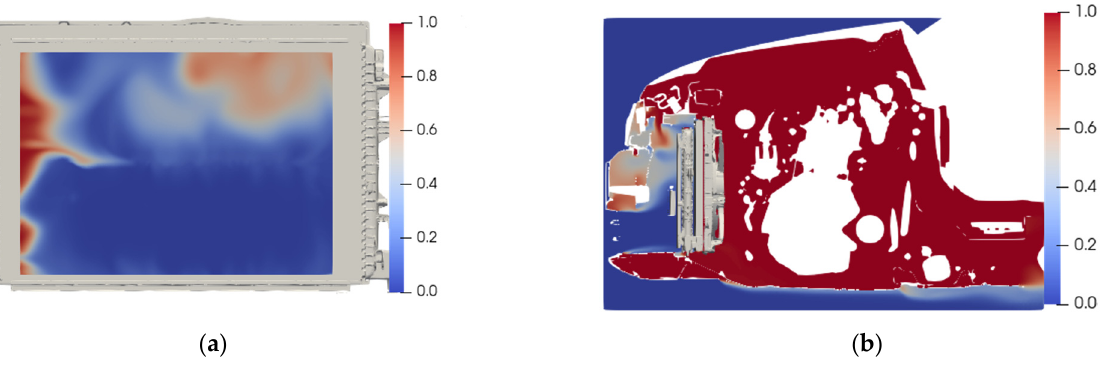
Figure 9. Backflow air distribution of original structure. ( a ) Backflow air distribution front view; ( b ) backflow air distribution side view.